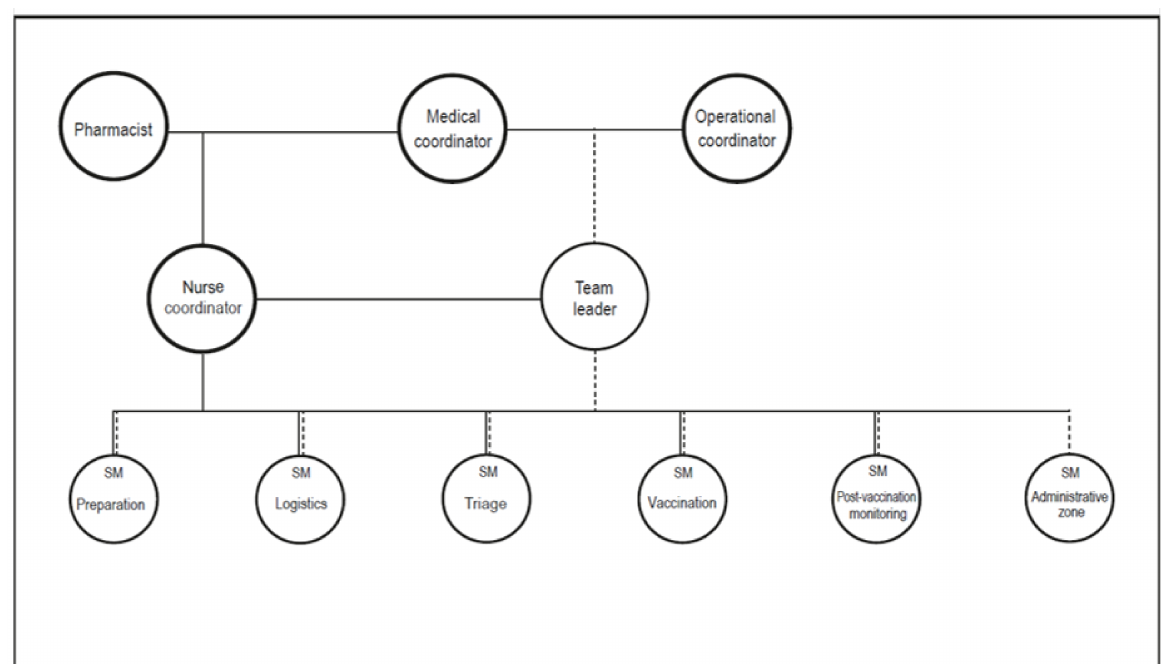
Figure 1. Toulouse Mass Vaccination Center command system. Full line – medical and para-medical supervision; dot line—administrative